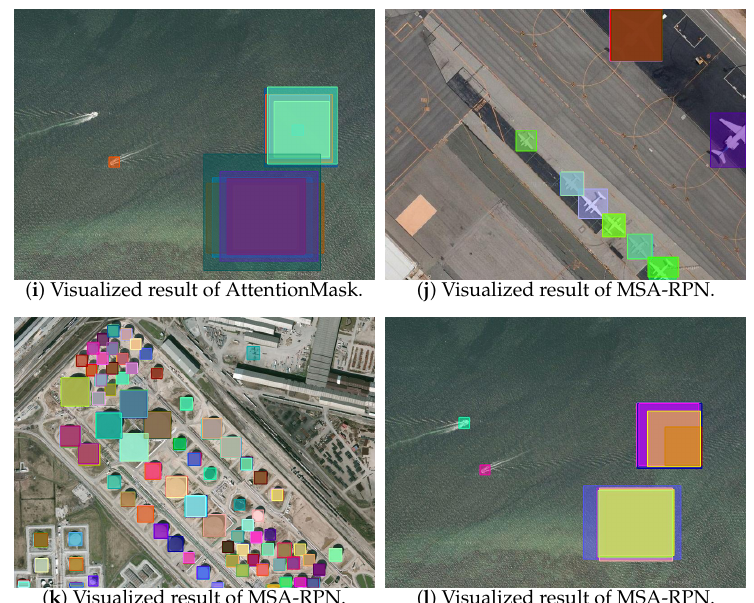
Figure 5. Visualized result of MSA-RPN and the other algorithms.